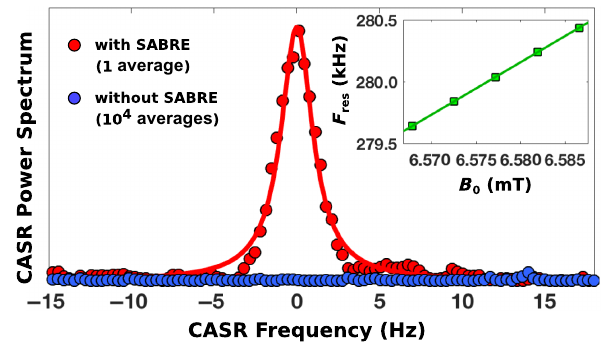
FIG. 2. SABRE-enhanced NV-NMR spectra of pyridine. Comparison of measured NV-NMR spectra of 100 mM pyri- dine sample with (red circles, one acquisition) and without (blue circles, 10 4 acquisitions) SABRE hyperpolarization for a CASR pulse sequence duration of 2 s. The solid red line is a Lorentzian fit to the SABRE-enhanced NV-NMR spectrum, giv- ing a linewidth of 2.3(5) Hz, a signal enhancement of about 2.22 ( 3 ) × 10 5 , and a proton spin polarization of 0.503(7)%, with √ Hz for a SNR a proton number sensitivity of 66.48(15) fmol / of 3. Small side peaks in the CASR spectra and deviations from the Lorentzian fits may arise from technical artifacts in the exper- iment [10]. The inset shows the CASR resonance frequency F res of hyperpolarized pyridine (green squares) obtained by our vary- ing the bias magnetic field B 0 . A linear fit (green line) of F res versus B 0 gives γ p = 42.5355 ( 40 ) MHz/T, consistent with the proton gyromagnetic